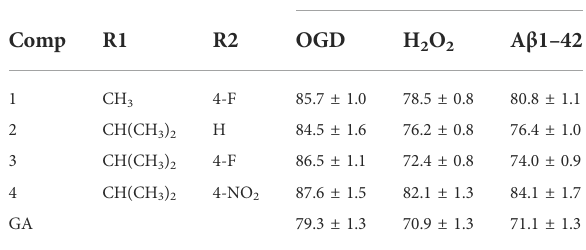
TABLE 1 Chemical structures of the four derivatives and comparison of cell viability of GA with four derivatives at 10 μ M (Zhang et al.,